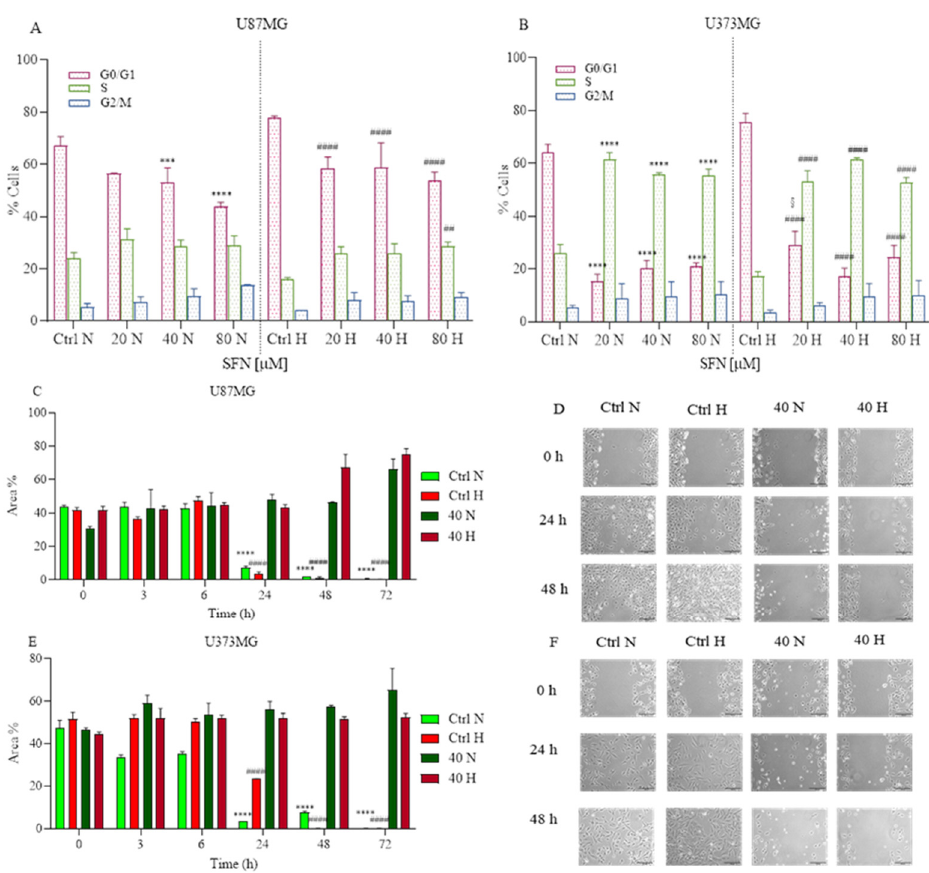
Figure 3. Effects of SFN on cell cycle ( A , B ) after 48 h of treatment [20–80 µ M] and cell motility after [40 µ M] treatment up to 72 h in normoxic or hypoxic conditions. SFN reduces GBM cell proliferation increasing the number of cells in the S-phase in both U87MG ( A ) and U373MG ( B ) cell lines. Cell motility showed in U87MG ( C , D ) and U373MG ( E , F ) that SFN suppressed GBM cell migration and proliferation both in hypoxic and normoxic conditions. Quantitative analysis of the area percentage of the wound not covered by U87MG ( C ) and U373MG ( E ) cells. Representative images of U87MG ( D ) and U373MG ( F ) cells at 0 h, 24 h and 48 h, 10 × magnification, scale bar 100 µ m. Data are expressed as the percentage of cells in the G0/G1, S, and G2/M phases ( A , B ) or as the percentage of the wound area not covered ( C , E ) and reported as mean ± SD of three independent experiments ( A , B ): *** p < 0.001 and **** p < 0.0001 vs. normoxic Ctrl group; ## p < 0.01 vs. hypoxic Ctrl group; § p < 0.05, vs. the respective normoxic treatment group. ( C , D ): **** p < 0.0001 vs. normoxic Ctrl group at time 0 h; #### p < 0.0001 vs. hypoxic Ctrl group at time 0 h. Two-way ANOVA, post hoc test Bonferroni).